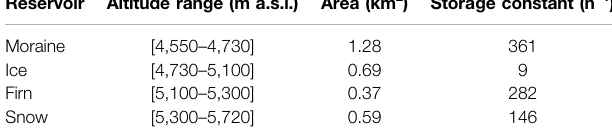
TABLE 3| Altitude range, area,andstorageconstantsusedforthelinearreservoir model. In the approach the altitudefor each reservoir were kept fi x since most of snowfalls at site are short-lived.